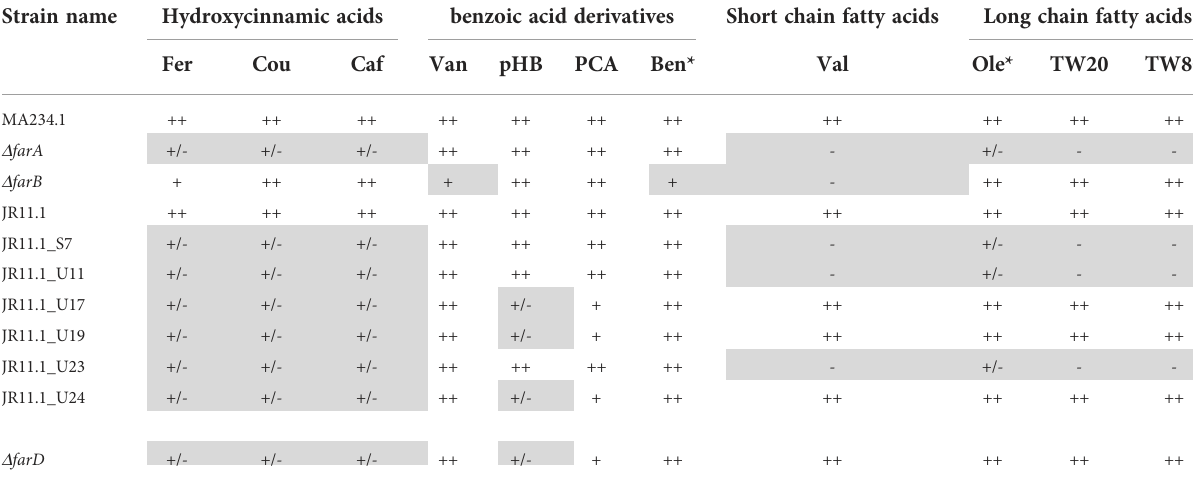
TABLE 2 Growth characteristics of D farA , D farB , D farD and JR11.1-derived